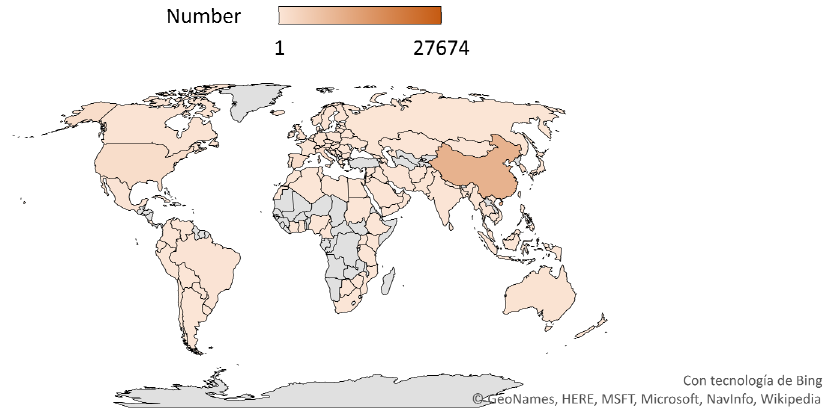
Figure 27. Author distribution by country.